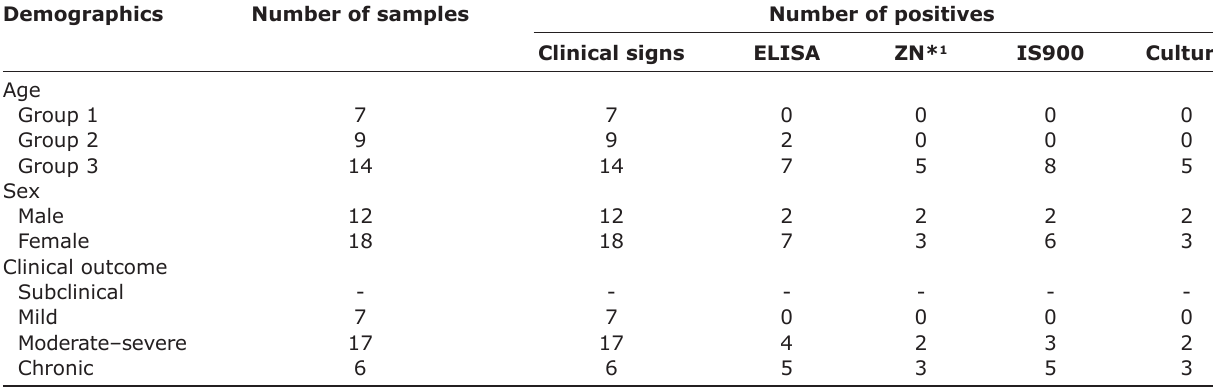
Table-2: Clinical disease outcomes (ranged from acute to chronic disease) of the camel cases in correlation to the isolation rate by different methods. Demographics